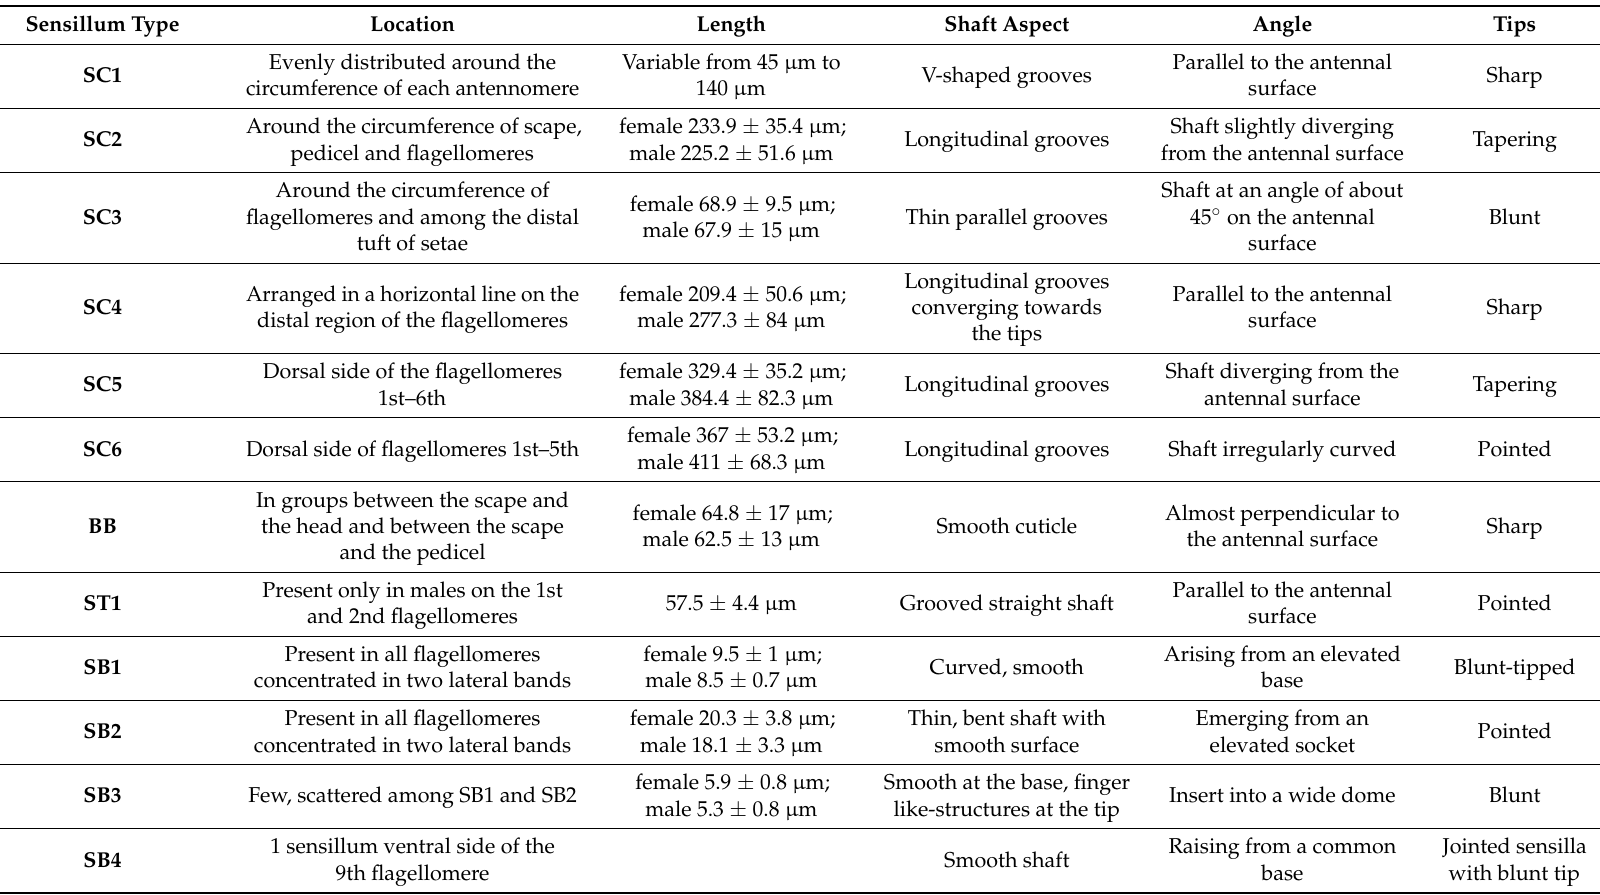
Table 1. Types of sensilla observed on the antennae of A. bungii